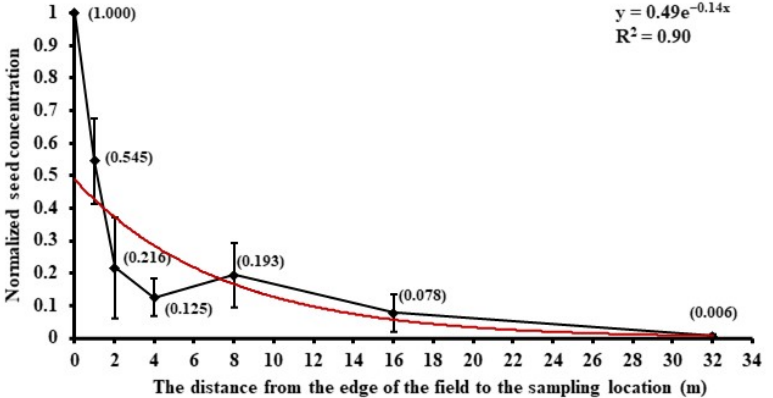
Figure 6. Vertical distribution of normalized seed concentration between the height of 0 and 100 m in the Illinois field (normalized by the concentration at the center of the field at 0.35 m height). The diamonds are means, and the bars are standard deviations.